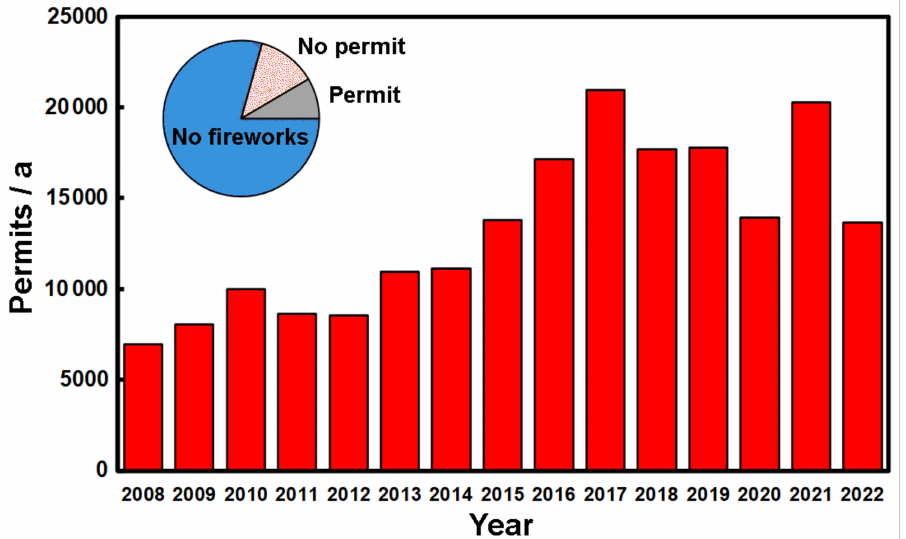
Figure 3. The number of fireworks permits issued before New Year [26]. The inset pie diagram shows the proportions of respondents who asked about obtaining a permit to buy and use fireworks for New Year’s Eve [39], which relates to the purchases for the celebrations of New Year